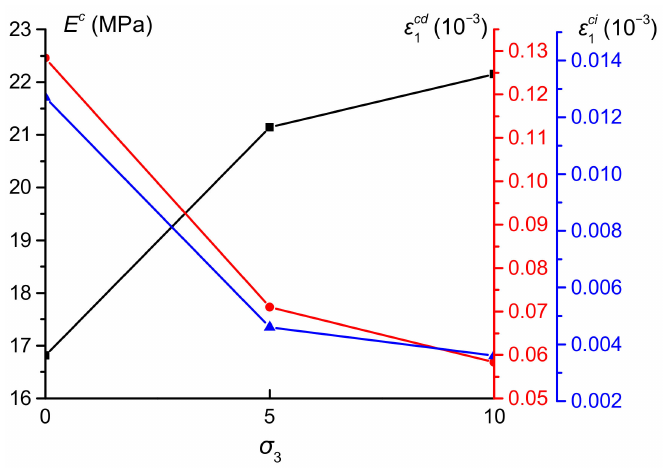
Figure 6. Effect of confining pressure on model parameters ε cd